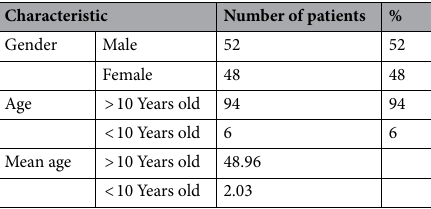
Table 1. Participants Demographics by Gender and Age.